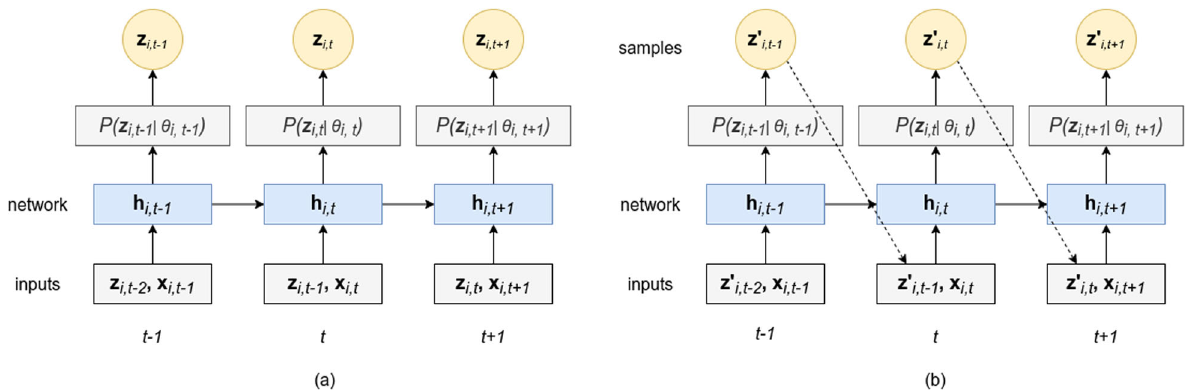
Fig. 2 Architecture of DeepAR network. a The basic working mechanism of the DeepAR architecture. Here, z i,t − 1 represents the input to the model and x i,t represents an optional covariate at time step t . The input z i,t − 1 is the target output at time step t − 1. This study does not have any covariates. During training, the DeepAR model tries to learn the parameters by minimising the error between the output value and the target value, at the output layer. b Validation and Prediction. At each time step t , samples are drawn from the output distribution, and the median of the samples is passed as an input to the next time step t + 1. This process is continued till the prediction length is